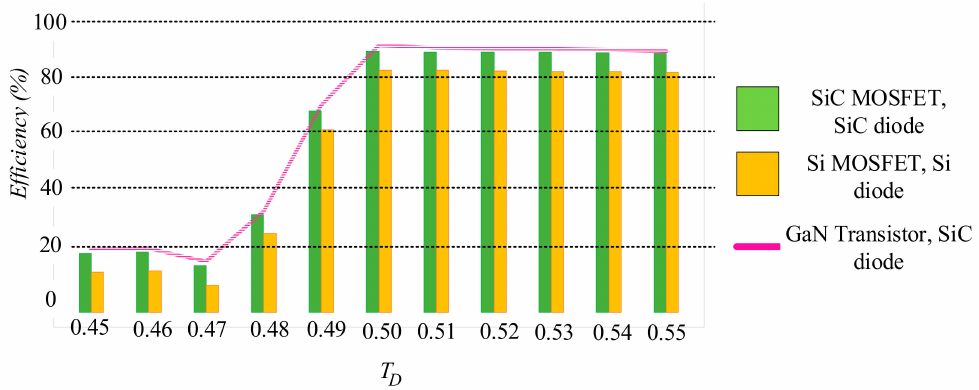
Figure 6. E ffi ciency versus time delay ( T D ) with di ff erent power